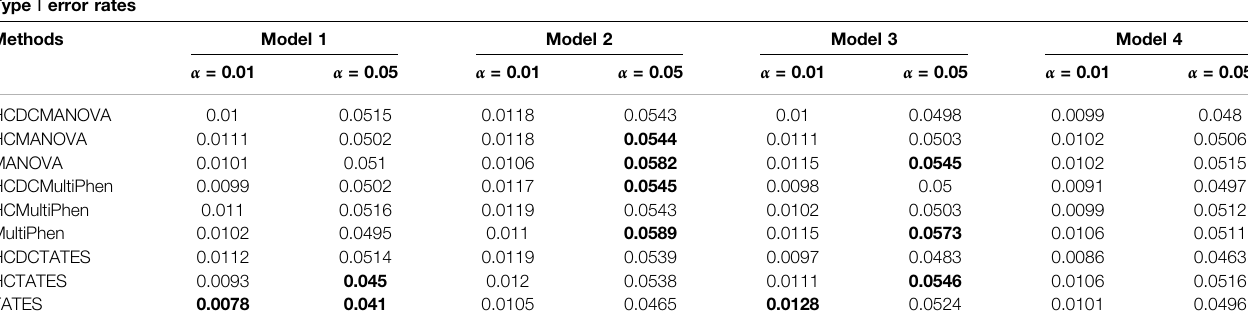
TABLE 2 | Evaluations of type Ⅰ error rates of the nine methods in four simulation